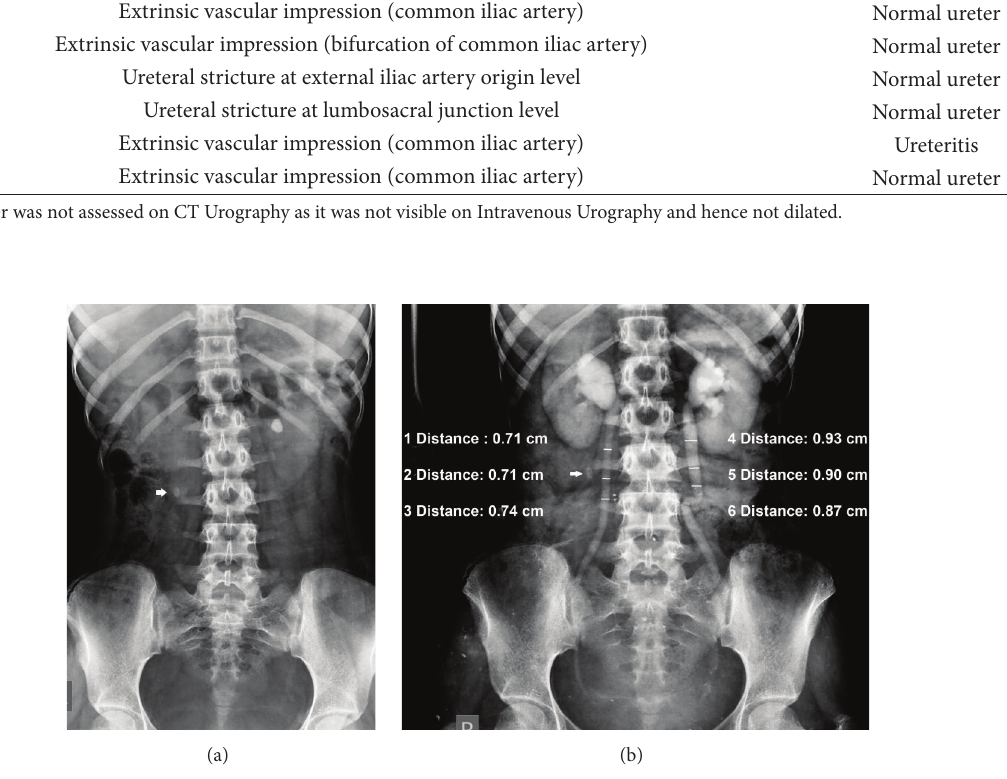
Figure 1: (a) Scout film shows a left renal calculus. An oval calcified node (arrow) lies outside the line of the ureter in (b). (b) Intravenous urogram shows dilated ureters with no apparent cause. Acid-fast bacilli on microscopic examination and culture of urine confirmed